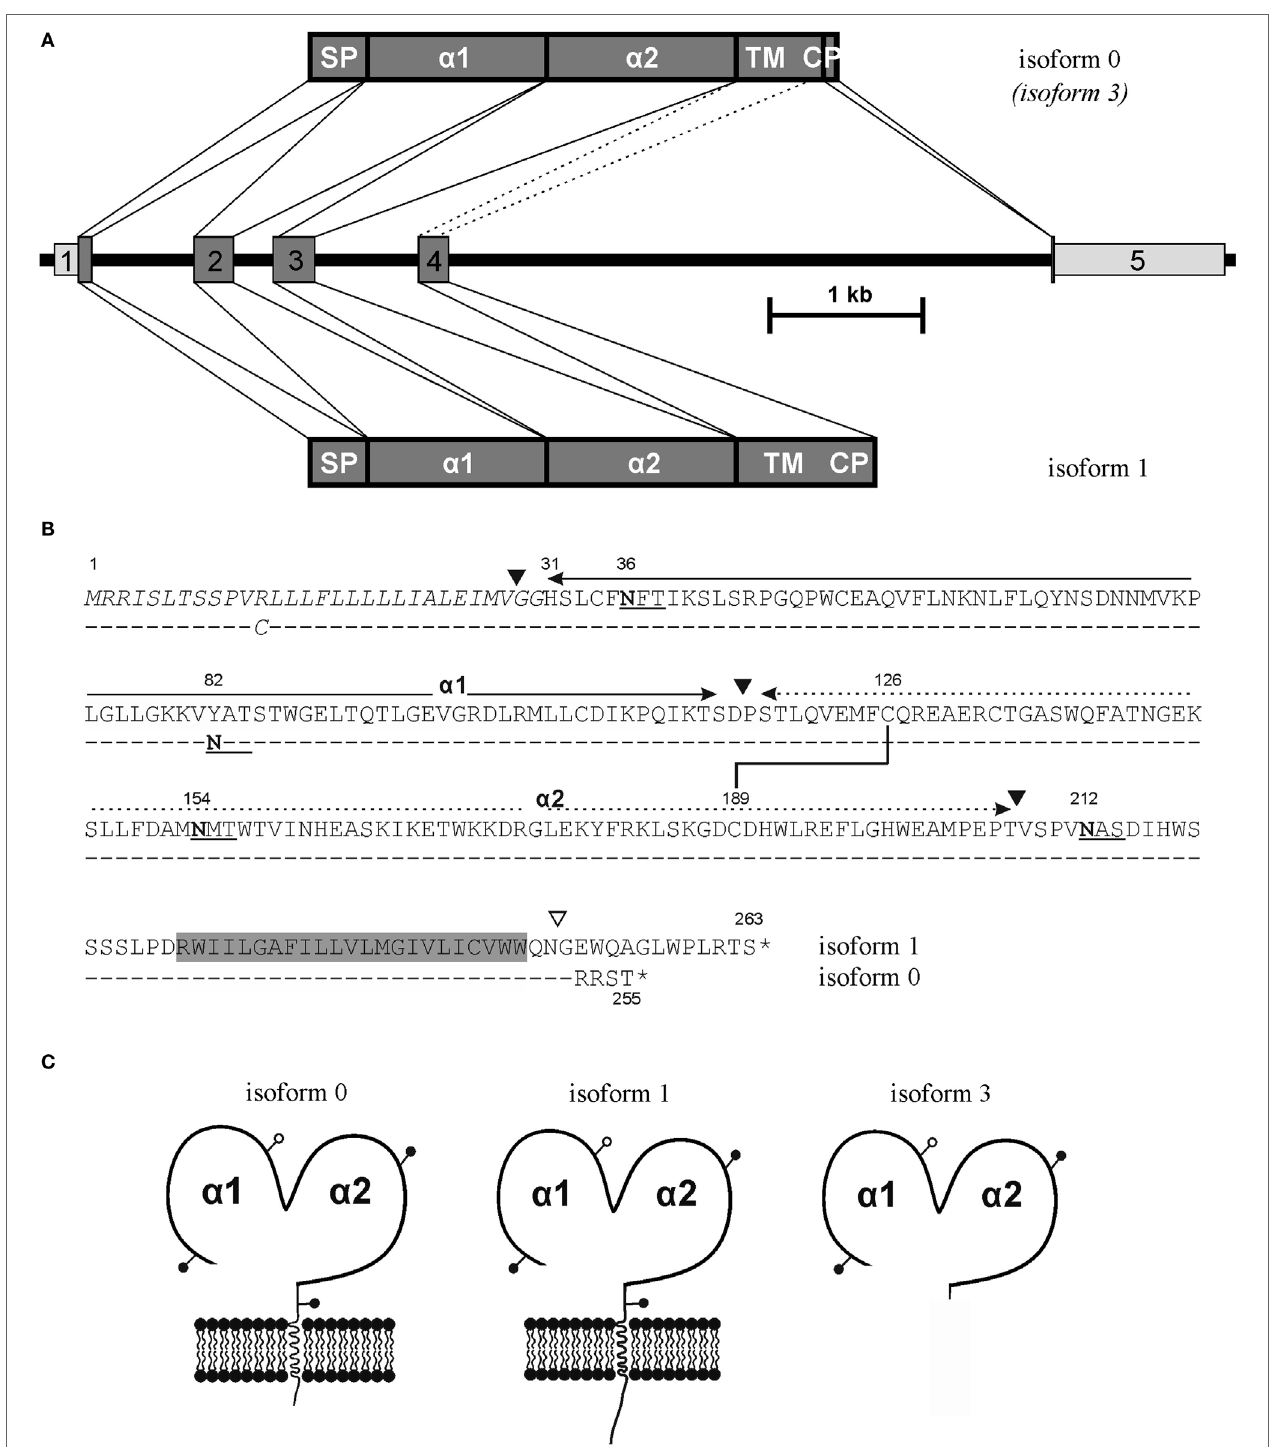
FigUre 1 | ULBP4 isoforms generated by differential splicing. (a) Differential usage of an internal splice site in exon 4 gives rise to the major full-length ULBP4 isoforms 0 and 1, respectively, while exclusion of exon 4 by alternative splicing (stippled lines) gives rise to the putatively secreted soluble ULBP4 isoform 3. Depicted is the exon–intron structure of the ULBP4/RAET1E gene and the alternatively spliced gene products representing isoforms 0, 3, and 1. (B) Amino acid sequence alignment of ULBP4 isoform 1 [upper; GenBank accession no. AY252119 (18)] and isoform 0 (lower; GenBank accession no. MH020173). Exon boundaries are indicated by black triangles except for the exon 4/5 boundary of isoform 0 (open triangle). N-linked glycosylation sites are underlined with asparagines in bold. Signal peptide sequence (Met 1 to Gly 30) is italicized, transmembrane domain highlighted in gray. Disulfide bond between Cys 126 and Cys 189 highly conserved in the MHC class I fold is indicated. (c) Scheme of ULBP4 isoforms 0, 1, and 3 with N-glycosylation sites indicated by pins.